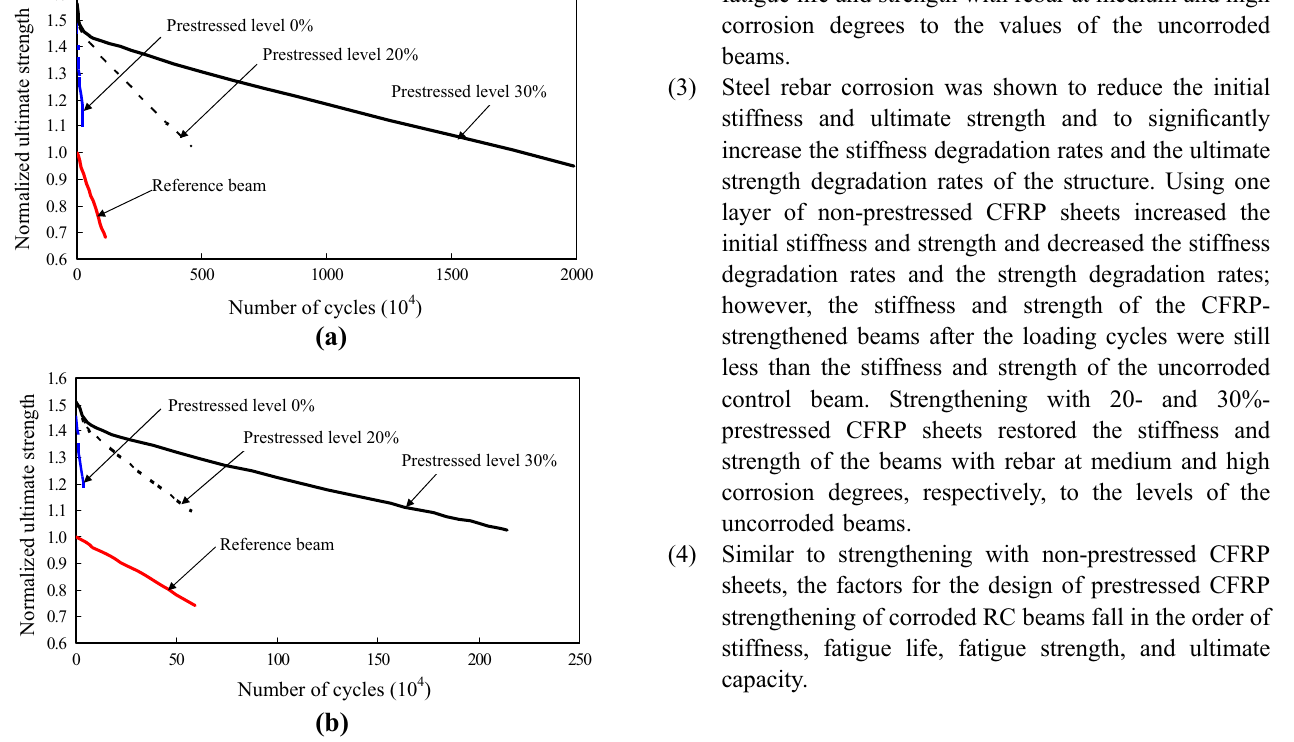
Fig. 9 Normalized ultimate strength degradation versus number of cycles: a 10% corrosion degree and 0.55 load level, b 15% corrosion degree and 0.60 load